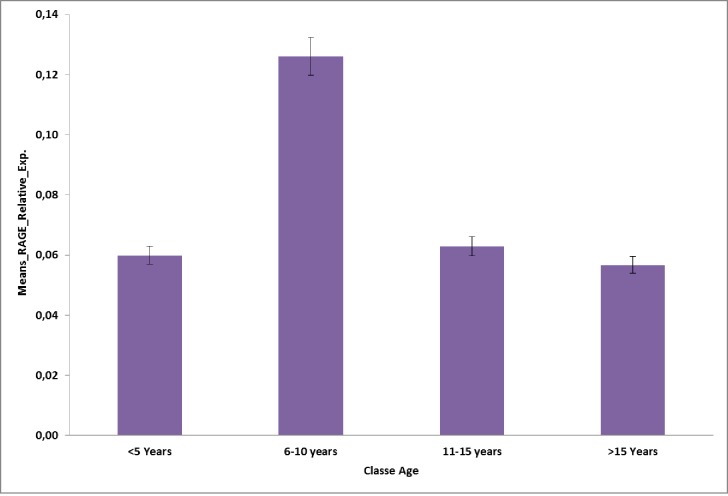
RAGE relative expression by age groups.